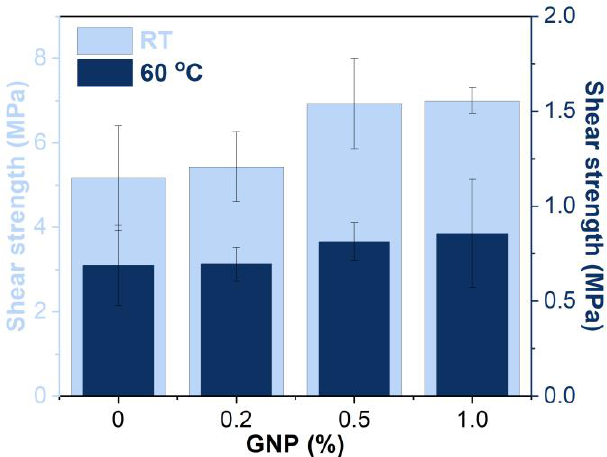
Figure 12. Shear strengths of GNP-reinforced EABCs at room temperature and 60 °C.